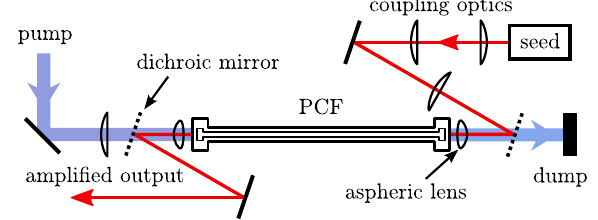
FIG. 2. Experimental arrangement for amplification in a PCF with coupling and decoupling aspheric lenses as well as dichroic mirrors to separate the pump and seed